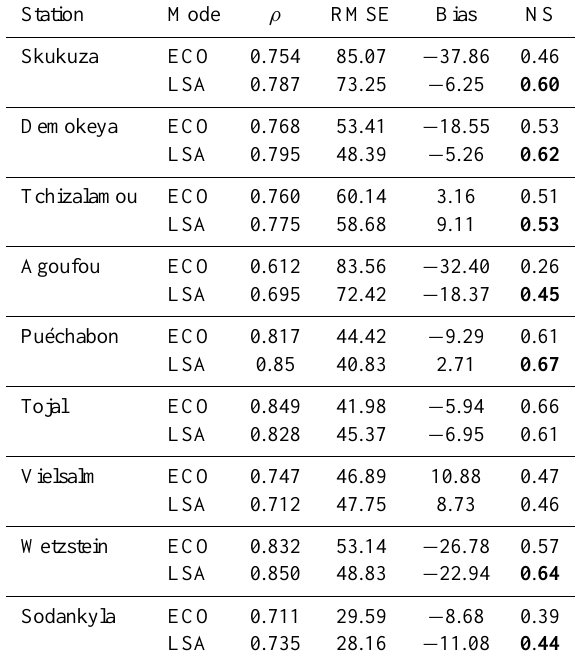
Table 3. Comparison of simulations with ECOCLIMAP-I (ECO) tistical scores: correlation coefficient ( ρ ), root mean square error (RMSE), bias and NS (Nash and Suttcliffe, 1970). Improved NS with LSA compared to ECO are in